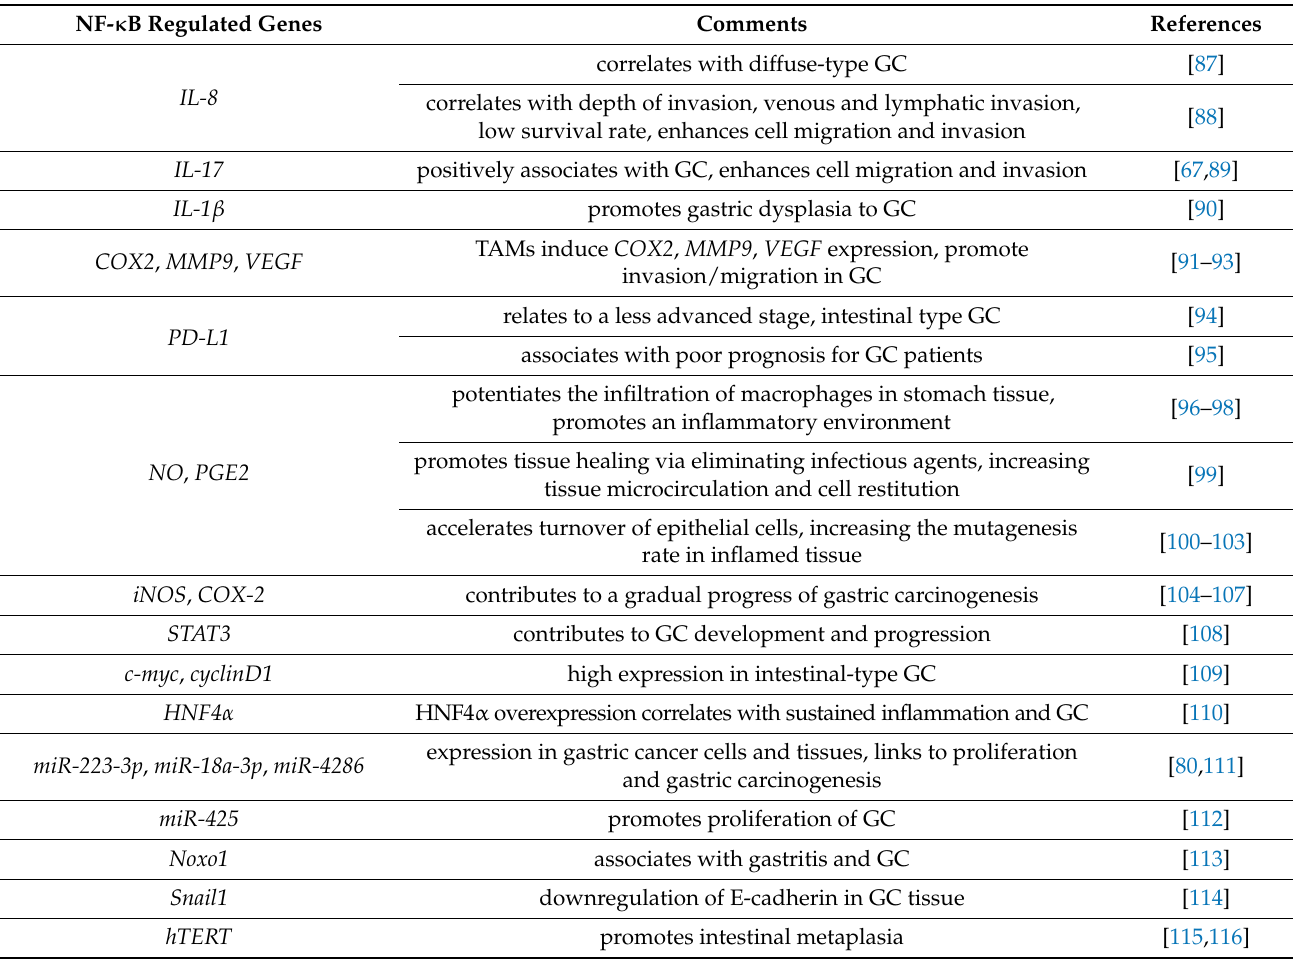
Table 2. NF- κ B-regulated genes and their relevance for gastric cancer